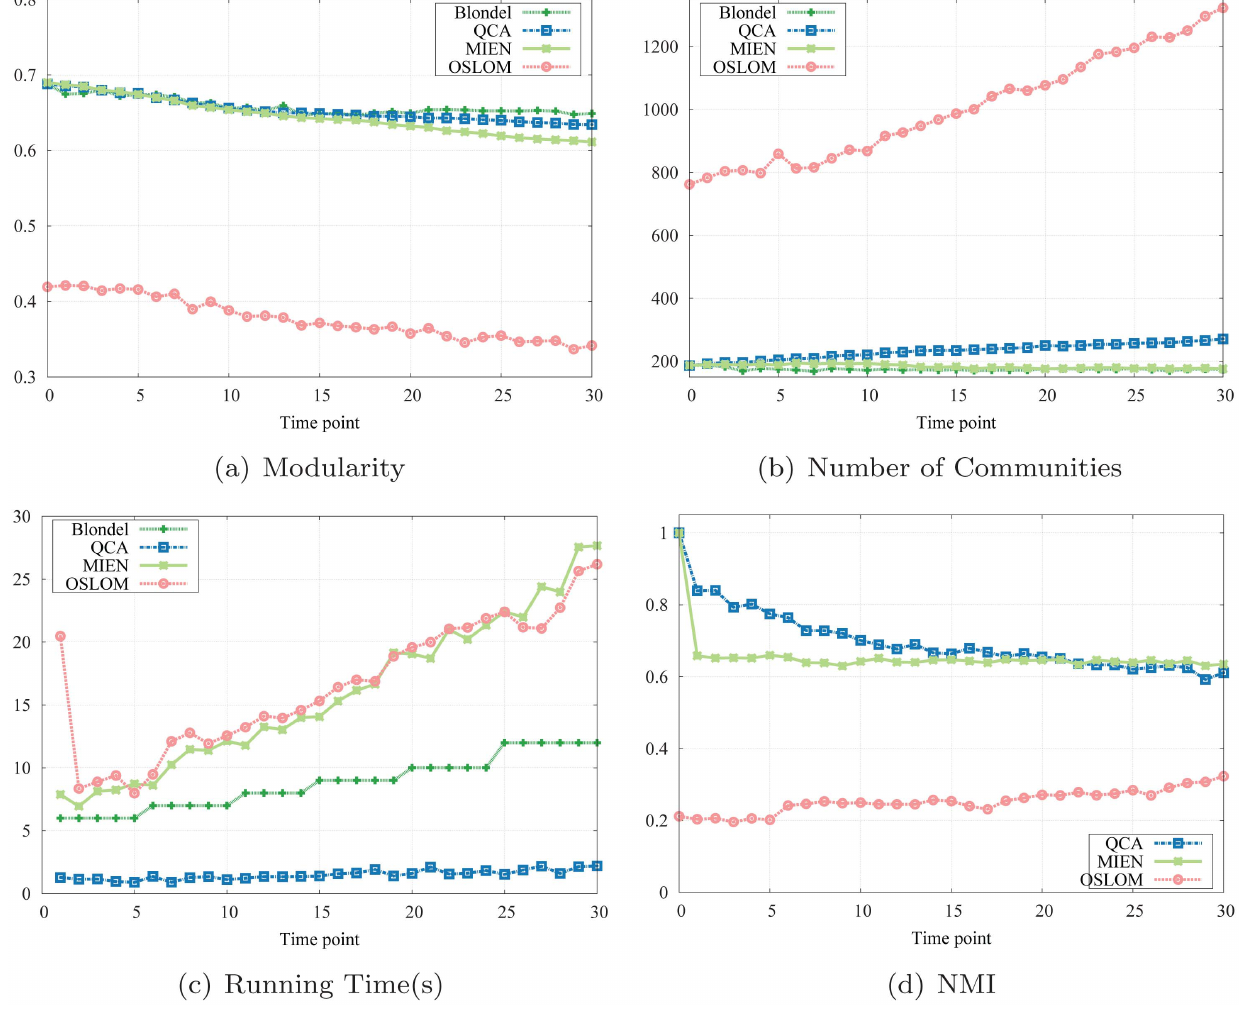
Figure 6. Simulation results on arXiv e-print citation network.